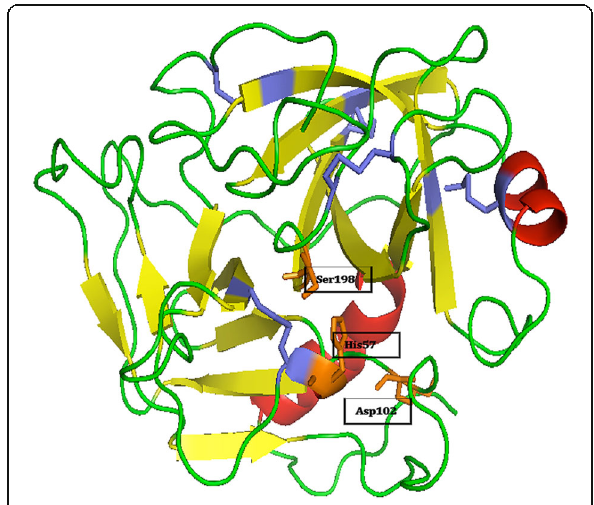
Fig. 3 Theoretical molecular modeling of gyroxin accomplished using Modeller and PyMOL programs. This serine protease has two α -helix structures ( red ) containing the residues 146 – 152 and 215 – 227, two β -barris structures formed by six antiparallel sheets and loops ( green ), five disulfide bridges ( blue ) and a catalytic triad ( orange ) Fig. 4 Crotalus durissus terrificus snake